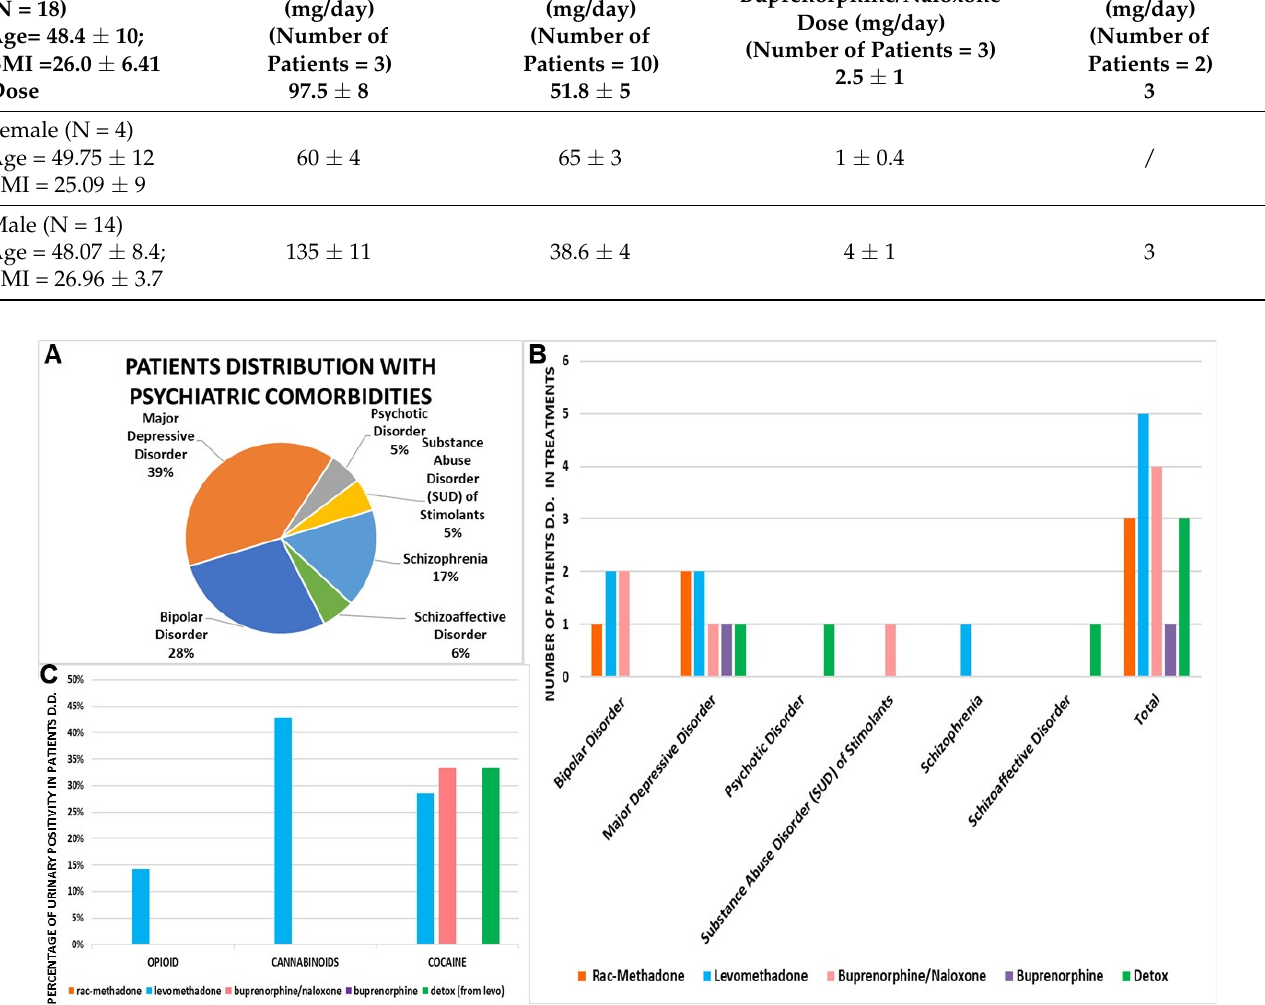
Table 8. Characteristics of the patients. BMI = body mass index. Table 9. Psychological indicators of disease. SCL90 = Symptom Checklist-90, a questionnaire used to assess psychological problems of 90 items.